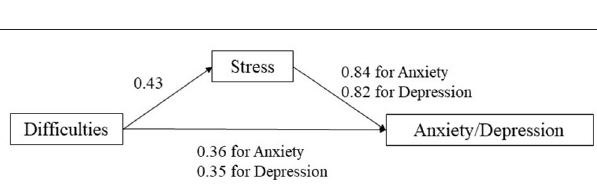
FIGURE 2 | Effects of difficulties on anxiety and depression with stress as the